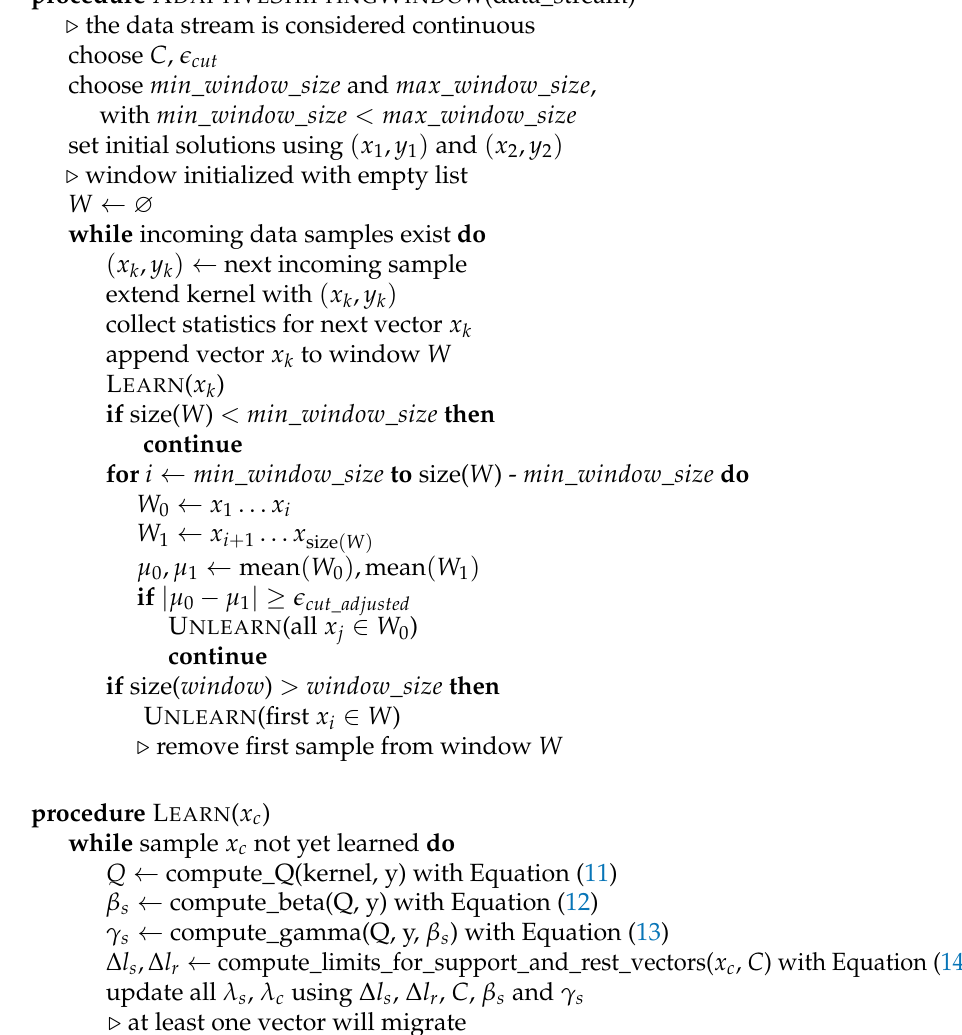
Algorithm 1 Concept drift AIDSVM learning and